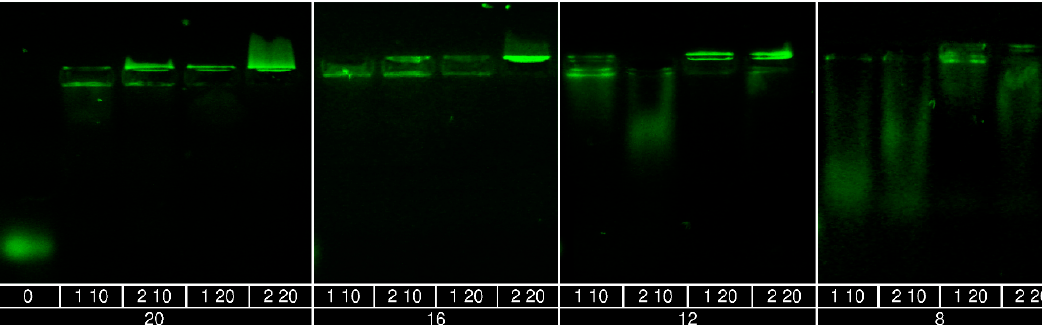
Figure 2. Gel electrophoresis data for PEI (1) and AKX-182 (2) complexes with duplex DNA (last row– length of the DNA), “0”–free DNA (similar blots were observed irrespective of DNA length). DNA concentration was 2.5 µM (calculating on DNA chains), N/P ratio presented as the second number in first row.